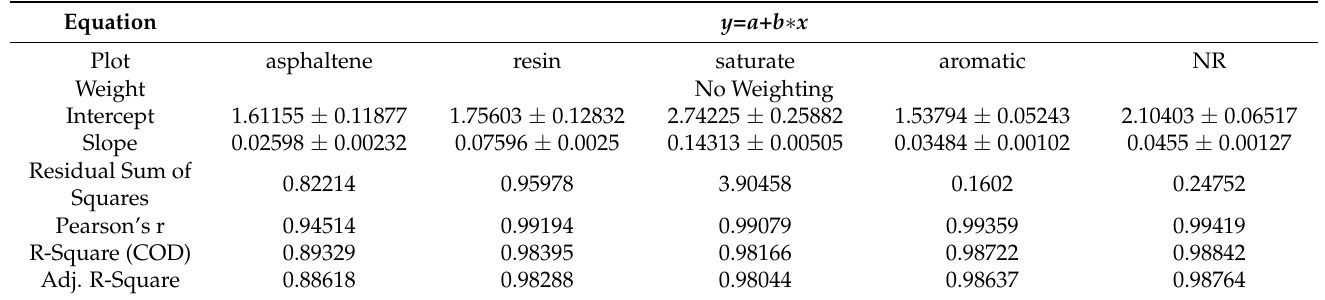
Table 6. MSD data analysis for PE/NR modified